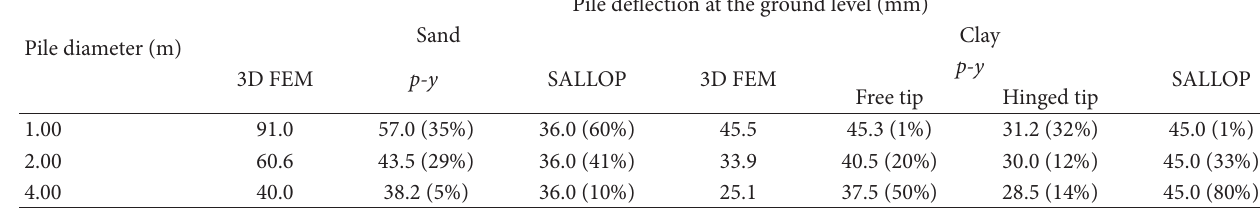
Pile diameter (m)